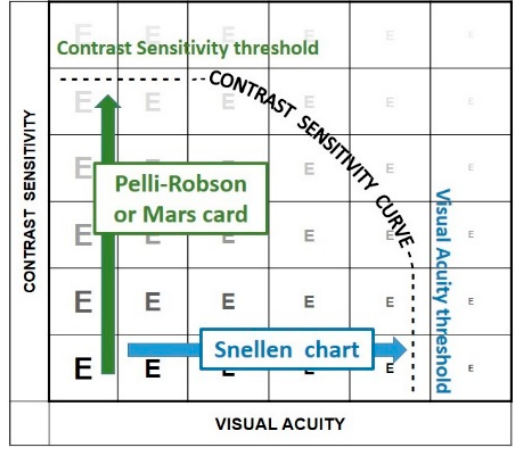
Figure 17. Threshold measurements.